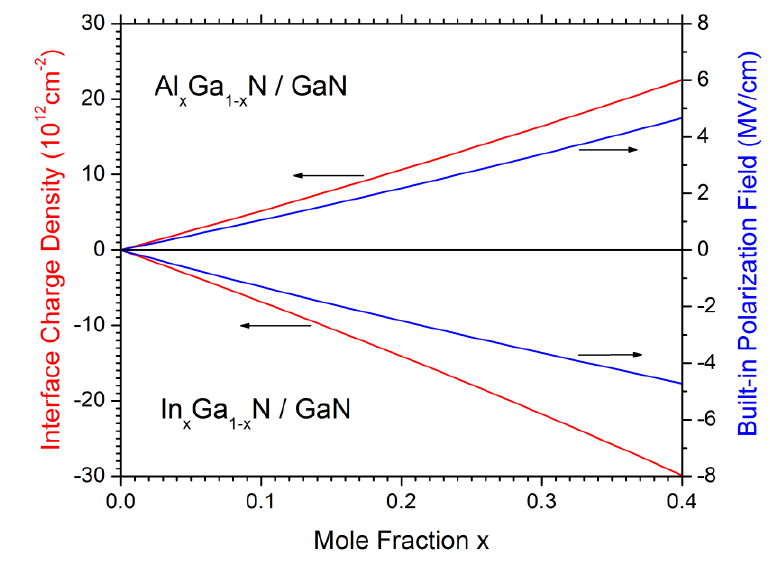
Figure 8. Net interface charge density and electrostatic field resulting from built-in III-nitride polarization [31]. InGaN grown on GaN results in a negative interface charge (cf. Figure 7) while growing AlGaN on GaN gives a positive interface charge.